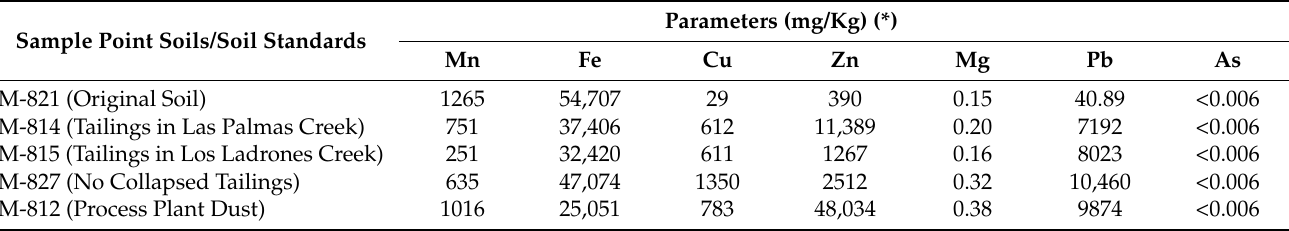
Table 7. Result of Chemical Analysis of Soil Samples compared with Soil Standards